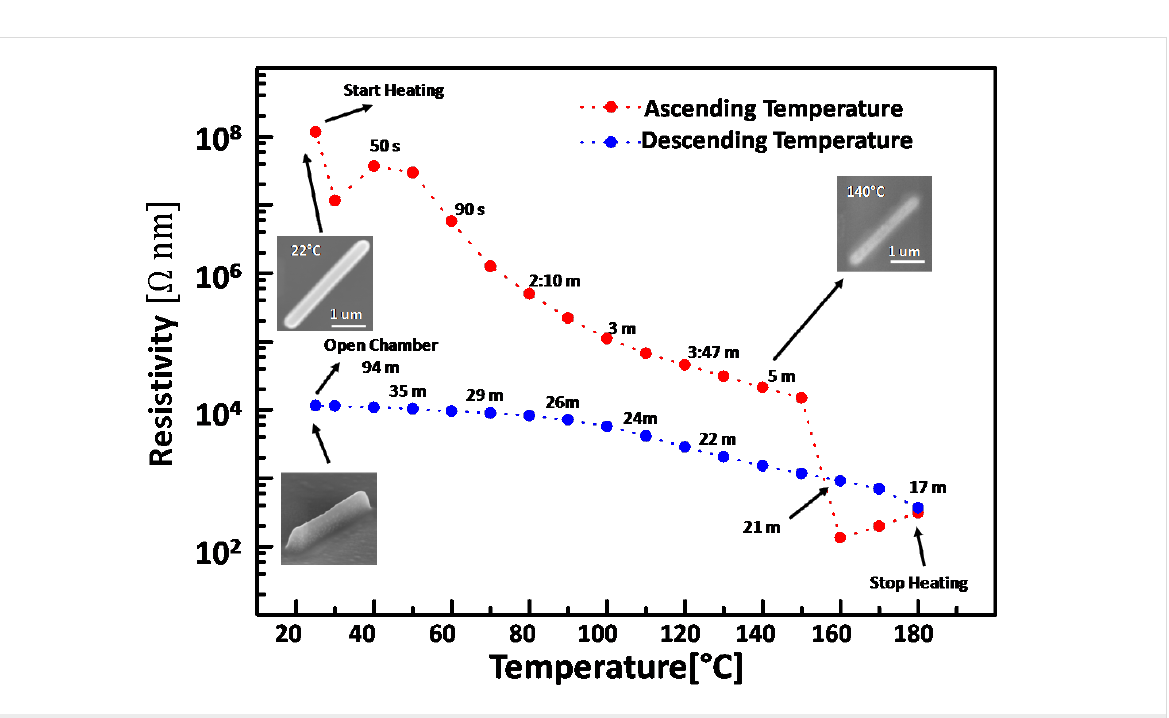
Figure 8: Calculated resistivity from the resistance measurement of a Cu–C line during in situ post-growth heating with a hot plate (red dots) and cooling down (blue dots) inside the SEM chamber. The resistance did not change when opening the chamber. The top SEM images show the morphology changes of an adjacent FEBID line which was observed simultaneously during the in situ resistance measurement.